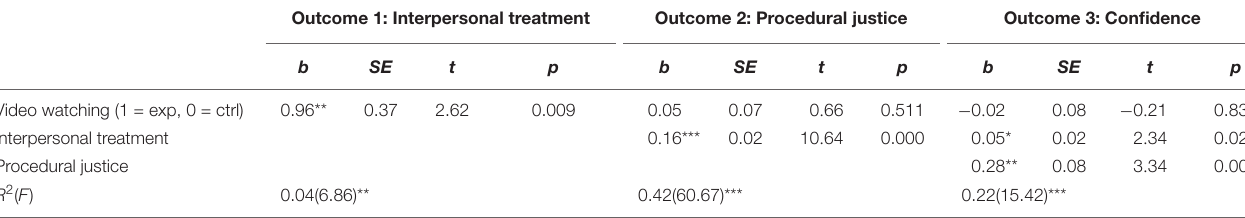
TABLE 3 | Mediation model testing the effect of video on confidence through interpersonal treatment and procedural justice. Outcome 1: Interpersonal treatment Outcome 2: Procedural justice Outcome 3: